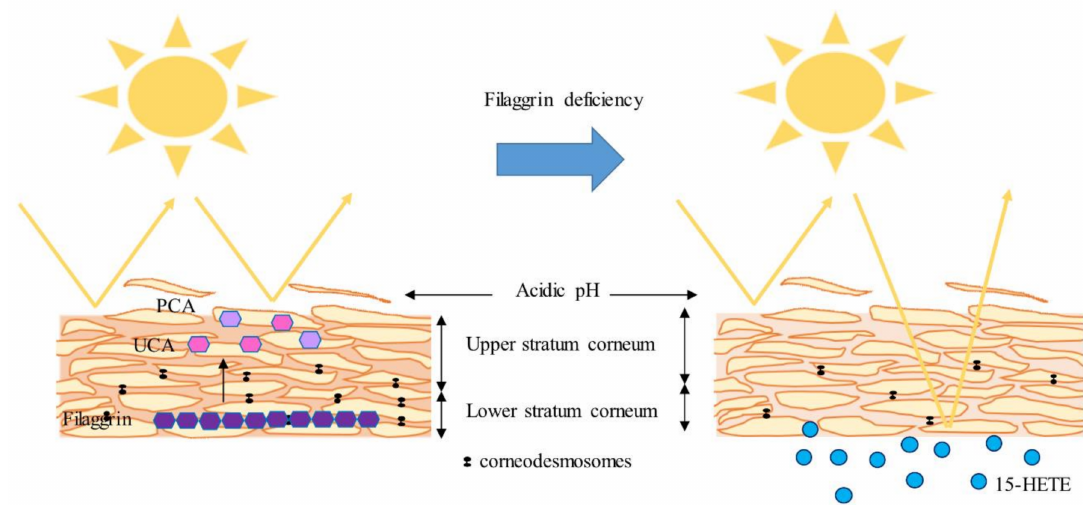
Figure 2. Lessons from IV 3D cultures. trans -urocanic acid (UCA) and pyrrolidone carboxylic acid (PCA) produced by Filaggrin (FLG) proteolysis likely serve as natural sunscreens. Accumulation of 15-HETE in IV epidermis might limit the extent of damage inflicted by UV-irradiation. FLG does not significantly contribute to the acidic pH of skin. FLG deficiency leads to an abnormal, but not completely defective, stratum corneum (SC) and has little or no e ff ect on the keratinocyte (KC) di ff erentiation process.